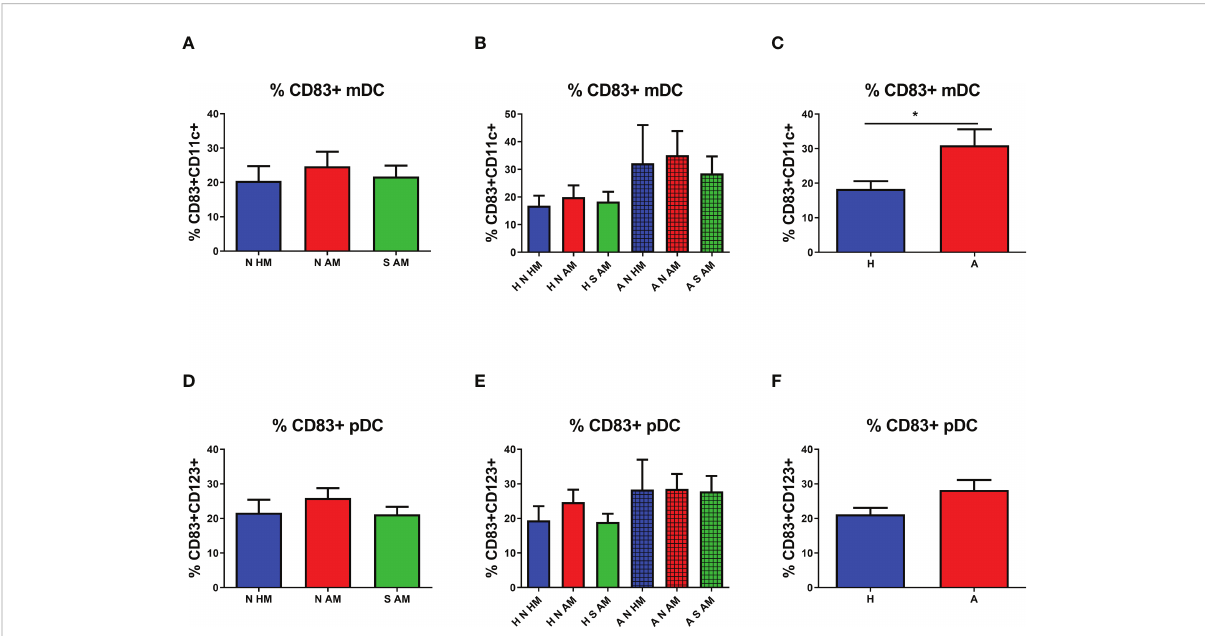
FIGURE 3 Proportion of CD83+ myeloid dendritic cells (mDCs) and plasmacytoid dendritic cells (pDCs) in the peripheral blood of 10-year-old children detected by fl ow cytometry. The presence of CD83 on mDCs of allergic non-supplemented children of healthy mothers (A N HM), allergic non- supplemented children of allergic mothers (A N AM), and allergic E coli O83:K24:H31-supplemented children of allergic mothers (A S AM) is documented in (A) The proportion of CD83+ mDCs in the peripheral blood of children divided according to their allergic status into the six subgroups is shown in (B) Levels of CD83 on mDCs of children divided only according to their allergic status are presented in (C) The proportion of CD83+ pDCs of N HM, N AM, and S AM is documented in (D) Numbers of CD83+ pDCs in the peripheral blood of children divided according to their allergic status into the six subgroups are shown in (E) The percentage of CD83 on mDCs of children divided only according to their allergic status are presented in (F) H N HM, healthy non-supplemented children of healthy mothers; H N AM, healthy non- supplemented children of allergic mothers; H S AM, healthy E coli O83:K24:H31-supplemented children of allergic mothers; A N HM, allergic non-supplemented children of healthy mothers; A N AM, allergic non-supplemented children of allergic mothers; A S AM, allergic E coli O83: K24:H31-supplemented children of allergic mothers; *p ≤ 0.0167 (adjusted p value). H, healthy children regardless of maternal allergy status or Escherichia coli O83:K24:H31 supplementation; A, allergic children regardless of maternal allergy status or Escherichia coli